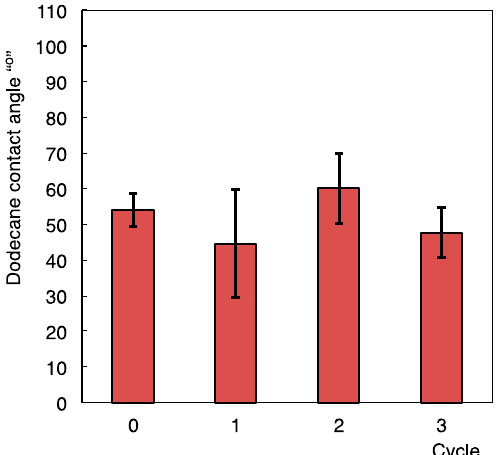
Figure 4. Relationship between the dodecane contact angle values on the modified cotton swatch and cycle of washing the modified cotton swatch with water.